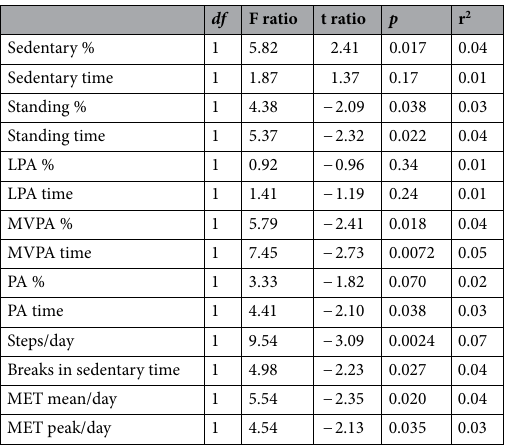
Table 4. Associations between fasting plasma glucose and accelerometer measures, least squares effect tests with sex and age included in the model. LPA light physical activity, MVPA moderate to vigorous physical activity, PA physical activity (LPA and MVPA together), MET the metabolic equivalent.